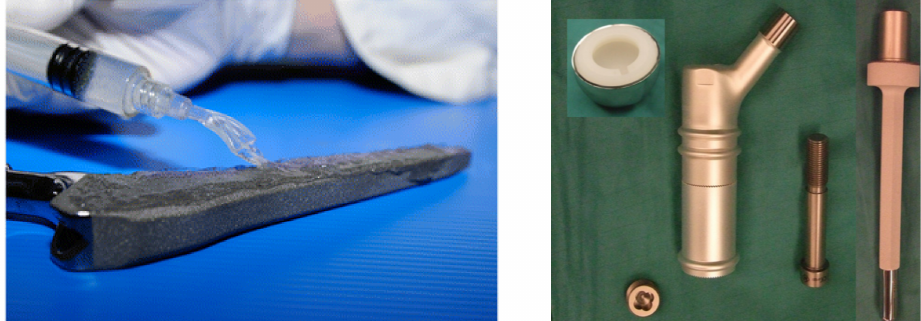
Figure 4. Left : DAC ® hydrogel coating spread onto a cementless hip prosthesis. Reproduced with permission from Journal of Orthopaedic Surgery and Research under the terms of the Creative Commons Attribution 4.0 International license (CC BY 4.0). Carlo Luca Roman ò , Sara Scarponi, Enrico Gallazzi, Delia Roman ò , Lorenzo Drago, Antibacterial coating of implants in orthopaedics and trauma: a classification proposal in an evolving panorama, Vol 10, Copyright (2015) published by Springer Nature [16]. Right : A new silver-coated prosthesis. Reproduced with permission from BioMed Research International under the terms of the Creative Commons Attribution 4.0 International license (CC BY 4.0). F. Donati, G. Di Giacomo, S. D’Adamio, A. Ziranu, S. Careri, MA. Rosa, G. Maccauro, Silver-coated hip megaprosthesis in oncological limb savage surgery, Vol. 2016, Copyright (2016) published by Hindawi